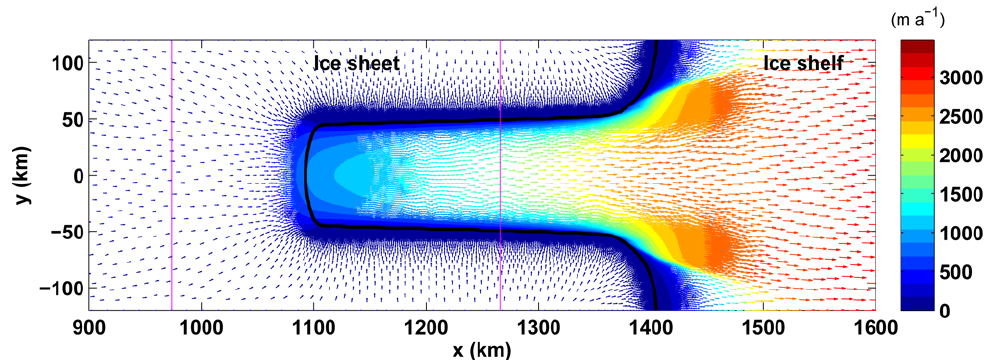
Fig. 2. Map-plane view of surface velocities obtained with the numerical code ´Ua for a channel half-width of w c = 50km. Values of all other model parameters are listed Table 1. The two magenta lines at x = 973 . 7km and x = 1265 . 7km indicate where bedrock slope in x direction is equal to zero. The strip 973 . 7km < x < 1265 . 7km is an area of retrograde slope where the bed slopes upwards in x direction. The grounding line marking the division between grounded and floating ice is shown as a thick black line. The arrows represent surface velocities, with the corresponding colorbar shown to the right. To make the direction of the shortest velocity vectors visible in the figure, the speed has been set to 100ma − 1 wherever calculated velocities are less than that value.